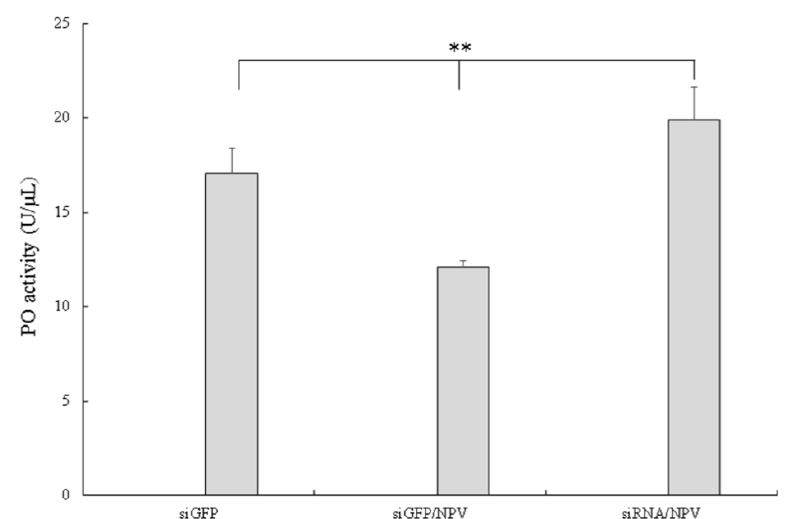
Figure 9. Knockdown of Bmserpin2 increased PO activity in cell-free haemolymph. PO activity was assayed using dopamine as a substrate, as described in “Materials and methods”. Haemolymph collected from GFP (siGFP), GFP infected with BmNPV (siGFP/NPV) and Bmserpin2 siRNA (siRNA2 target sequence) infected with BmNPV (siRNA/NPV) was used to measure PO activity. Error bars show mean ± SD ( n = 3). Statistical analysis was performed using SPSS software. Significant differences are indicated by * ( p < 0.05) or ** ( p < 0.01).